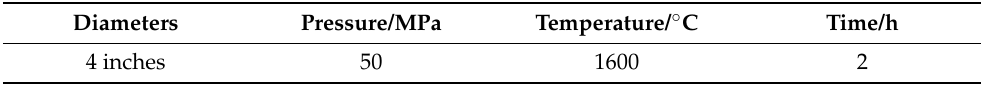
Table 2. Parameter of vacuum hot-pressing sintering.